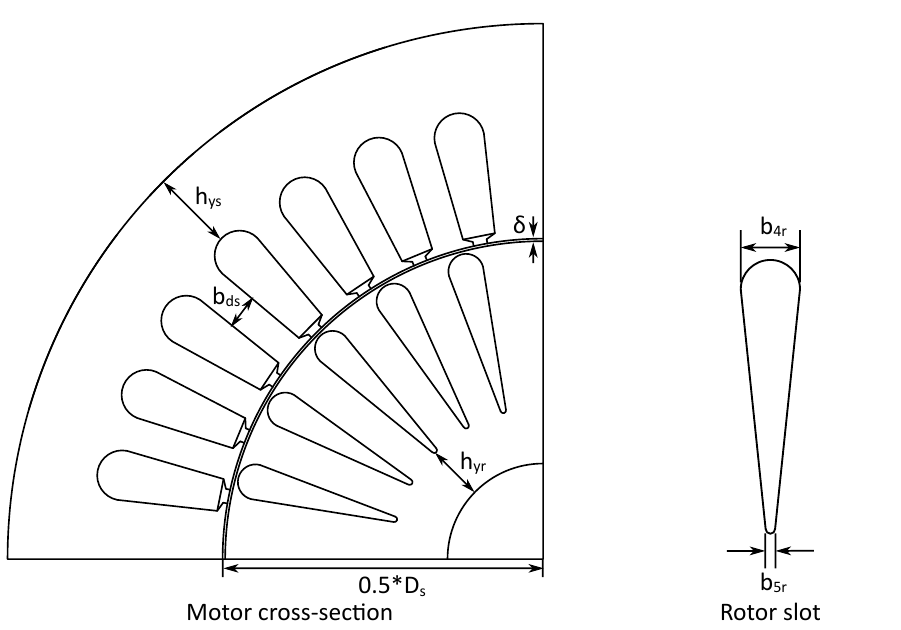
Figure 1. Optimization variables of the induction motor. Table 1. Specifications and fixed parameters of the induction motor.